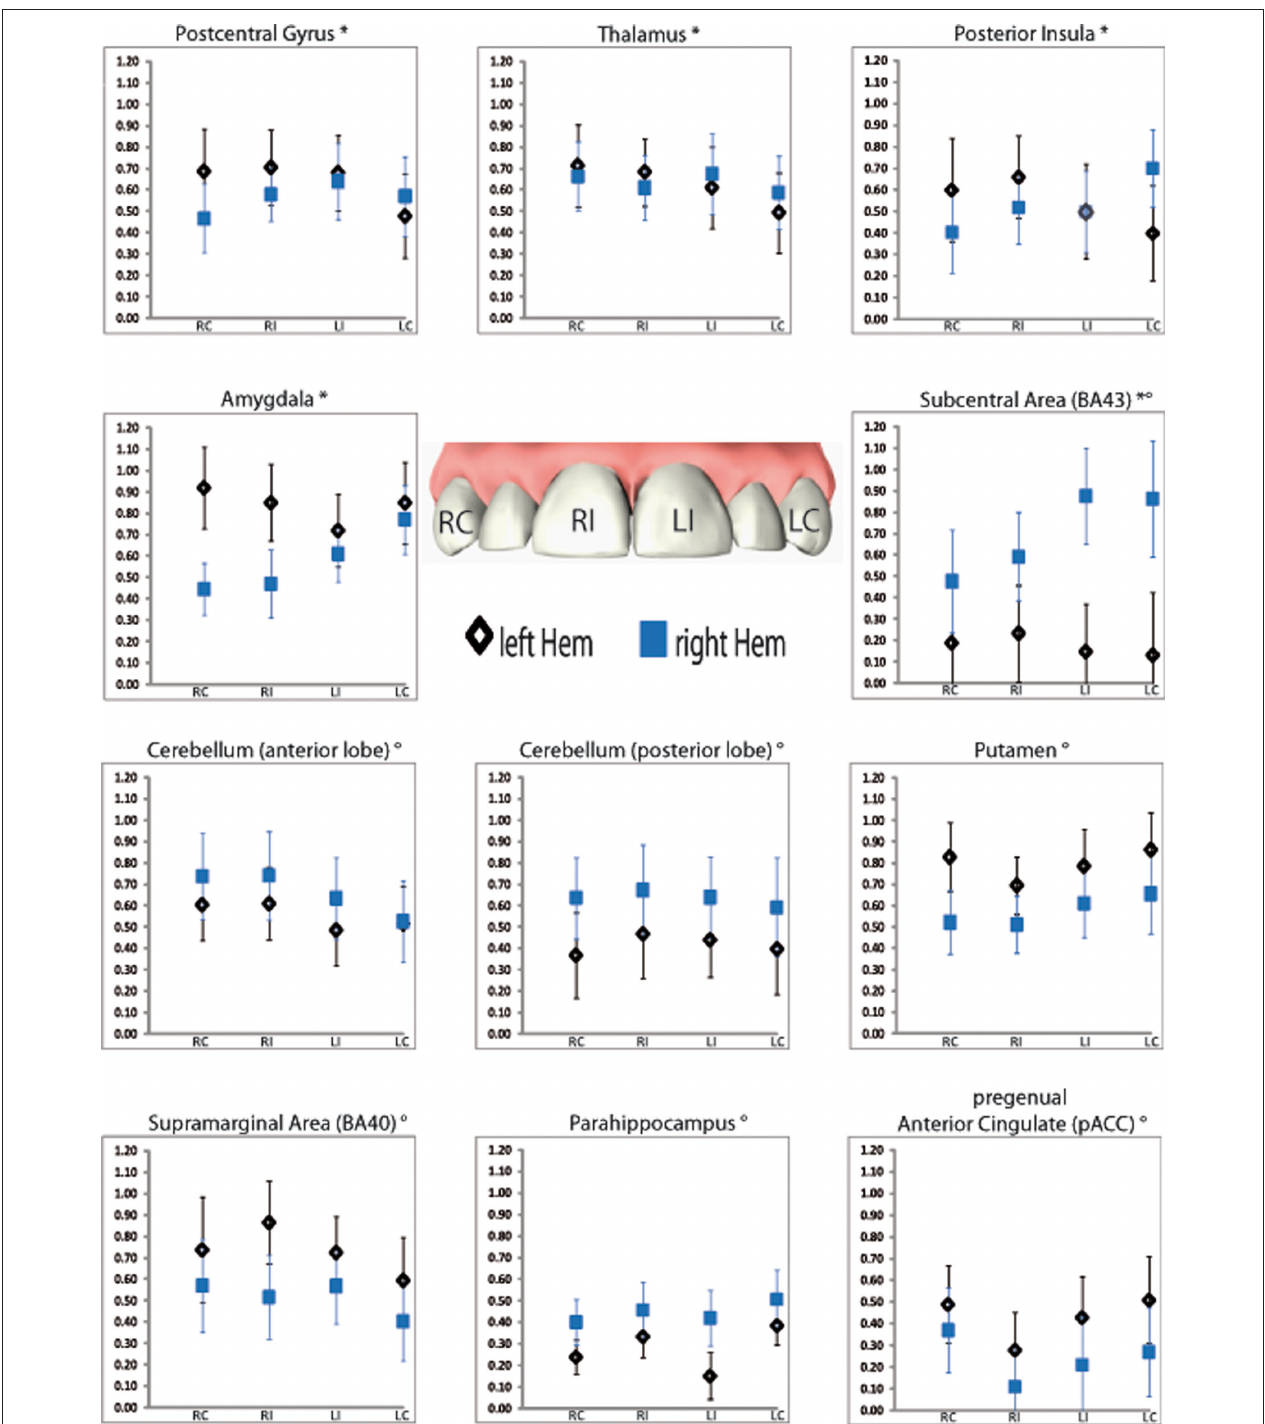
FIguRe 3 | Regions of interest (ROIs) showing significant main effect hemisphere (indexed with ° ) or interaction (indexed with *) in the repeated measure aNOva. Displayed are mean activations ( Y axis) with corresponded standard errors for each tooth within the respective hemisphere. RC, right canine; RI, right central incisor; LI, left central incisor; LC, left canine.